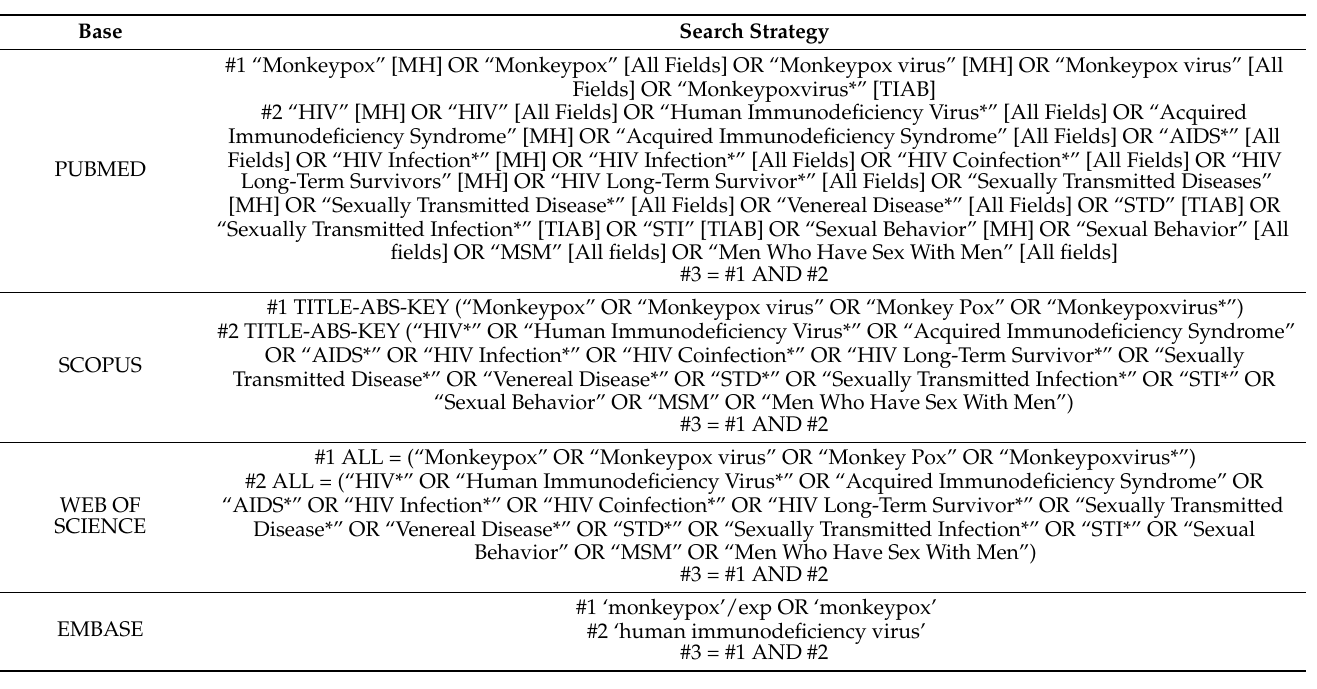
Table 1. Search approach for the literature. * NS: Not